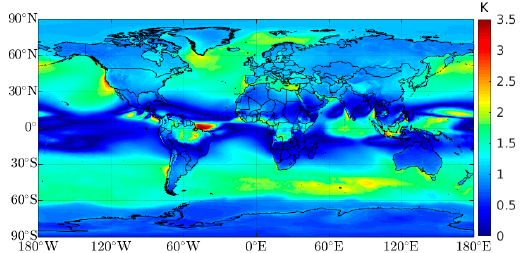
Figure 9. Accuracy spatial distribution for T m considering a global standard deviation of 1.1 K for surface air temperature and ignoring possible errors in α and β